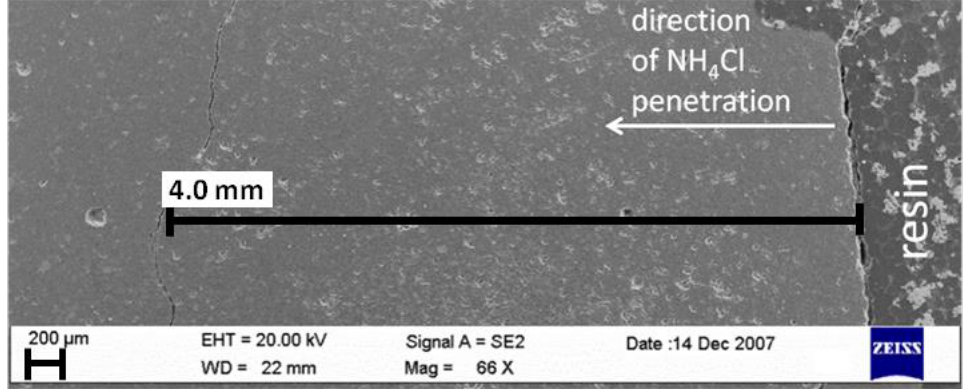
Figure 9. A micrograph of the polished section of sample B-19 with marked crack at a distance of at least 4.0 mm from the contact surface with the aggressive solution where the thaumasite started to dissolve.